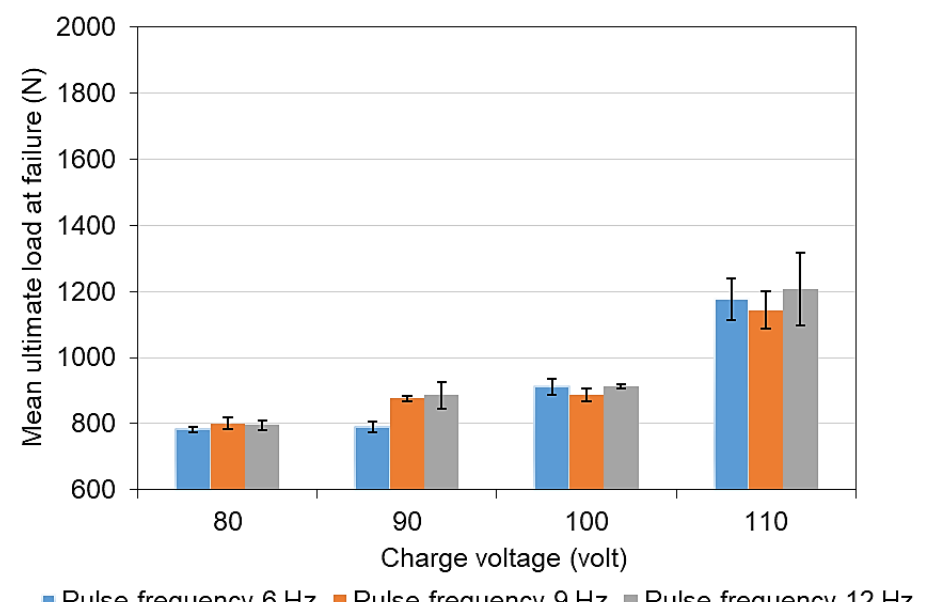
Figure 14. E ff ect of laser parameters on ultimate load at failure ± standard deviation (SD) (length of welding 5 mm).